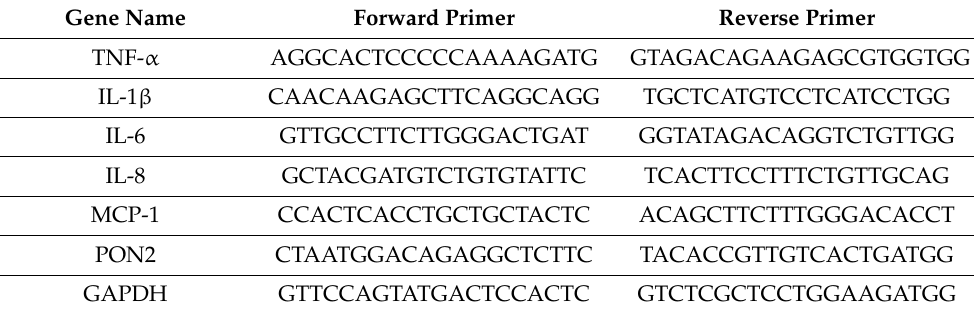
Table 1. Gene names and primer sequences (mouse) used in this